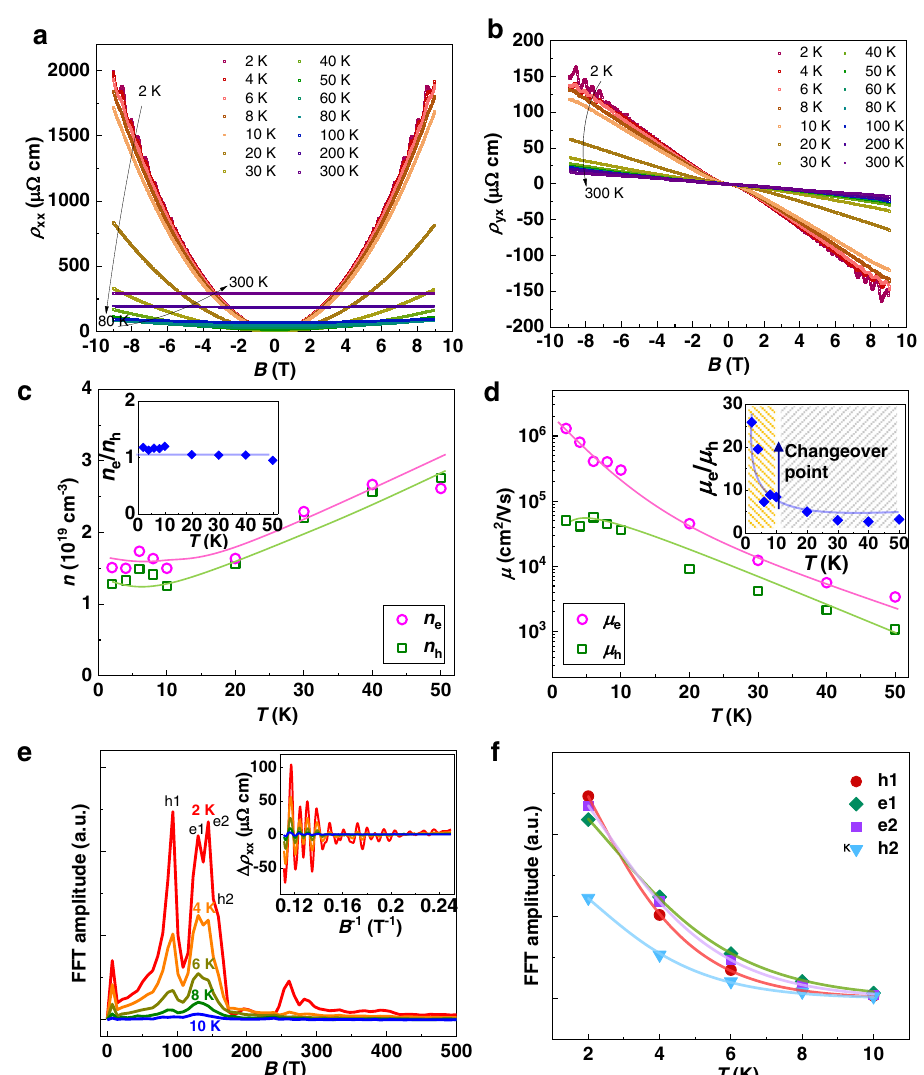
Fig. 3 Charge-carrier mobilities and effective cyclotron masses of WTe 2 . a Longitudinal resistivity as a function of magnetic fi eld. b Hall resistivity as a function of magnetic fi eld. c Carrier concentration. d Mobility of both electrons and holes. The insets in ( c ) and ( d ) present the ratios of the concentration and mobility of electrons to holes, respectively. e Fast Fourier transform (FFT) spectra of the oscillatory part of ρ xx at different temperatures from 2 K to 10 K. The inset shows the background-subtracted oscillations as a function of 1/ B . f Temperature dependence of the FFT amplitudes for the h1, e1, e2, and h2 Fermi pockets. The points are experimental values and the lines are fi ts according to the Lifshitz – Kosevich formula 35